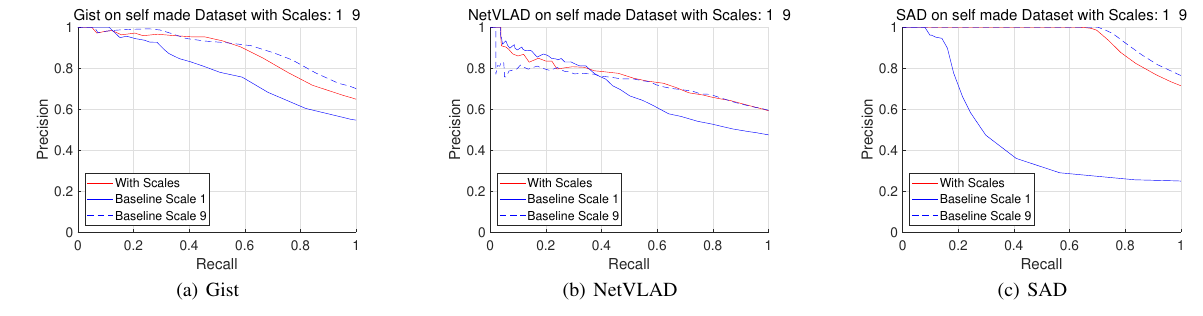
Figure 7. Recognition performance for multiple scale